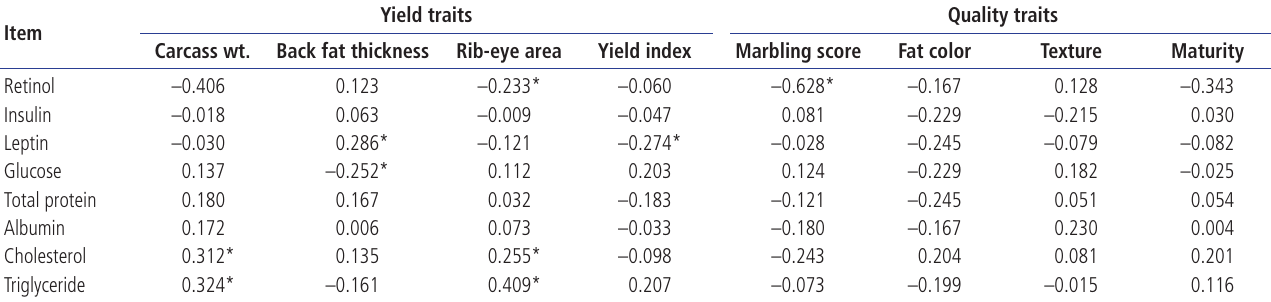
Table 7. The correlation coefficients between plasma biochemical compositions and carcass traits of Hanwoo steers Yield traits Quality traits Item Carcass